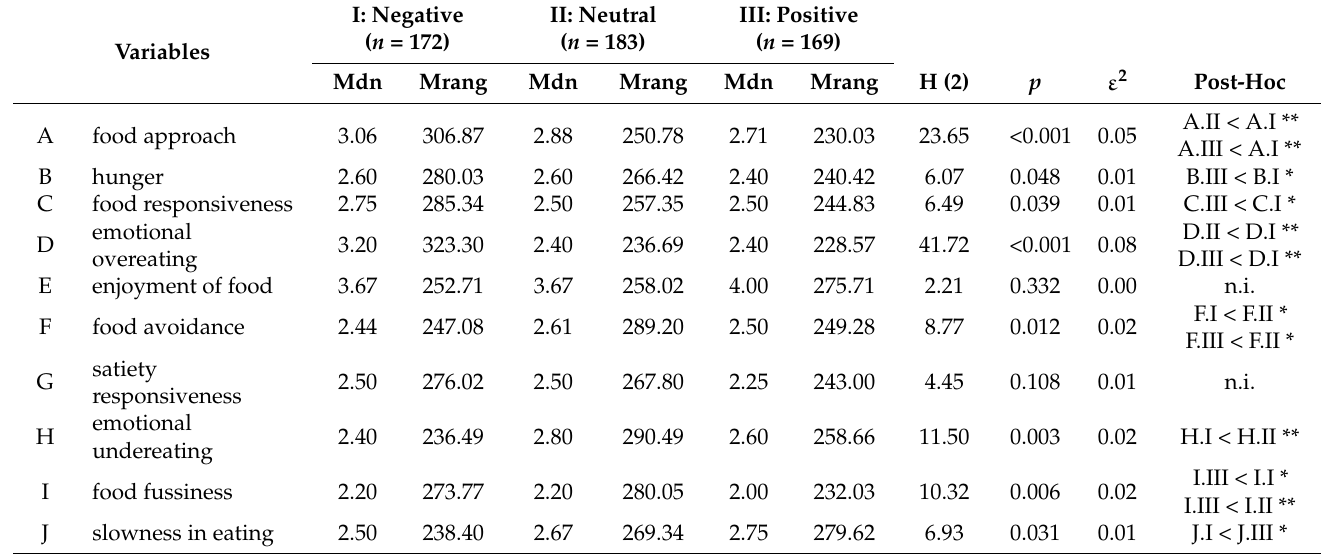
Table 11. Results of intergroup comparison using Kruskal–Wallis H test, along with post hoc tests on AEBQ-questionnaire dimensions and types of perception of body image and